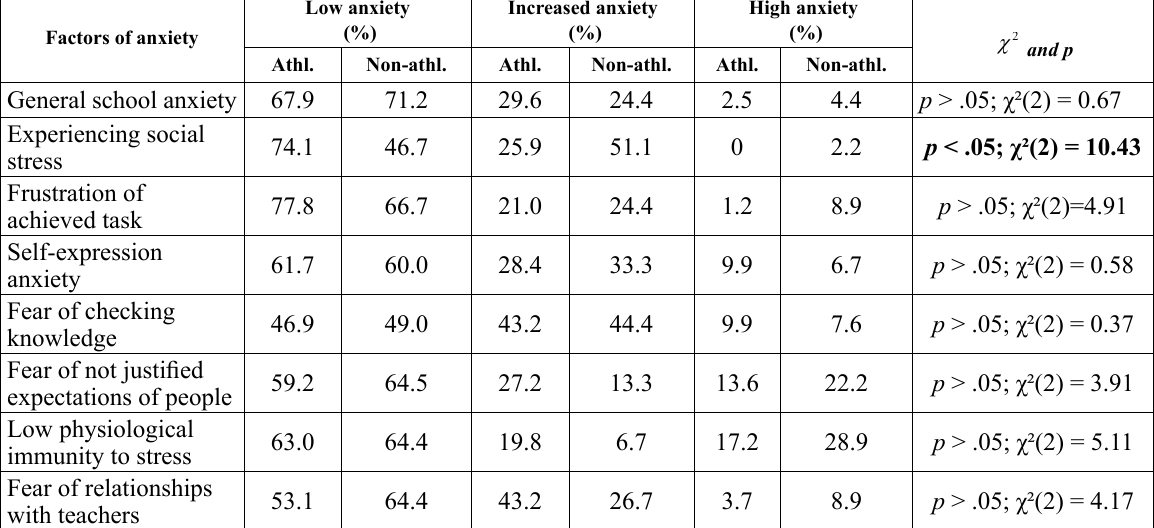
Table 2. Comparison of anxiety factors in adolescent athletes and non-athletes Factors of anxiety